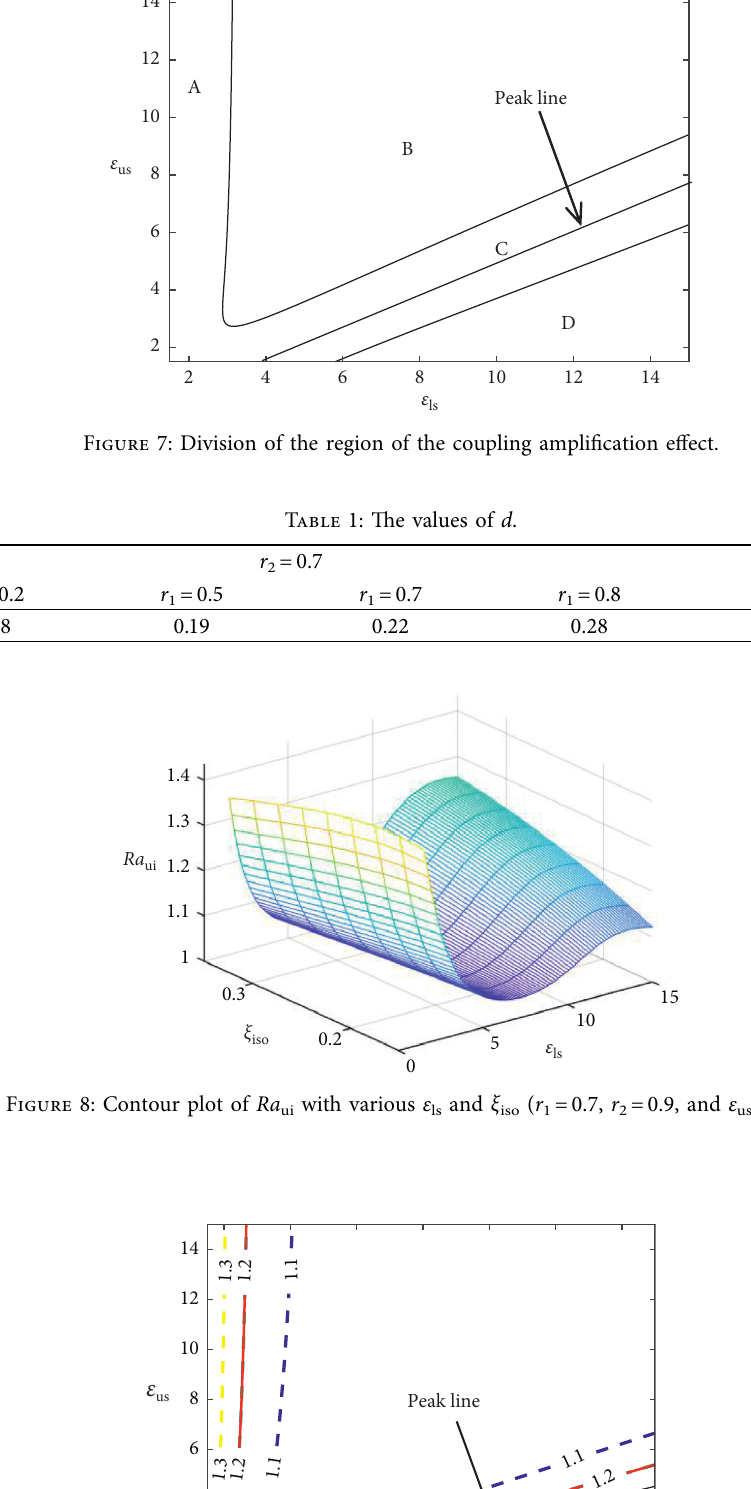
ui with various ε ls and ξ iso ( r 1